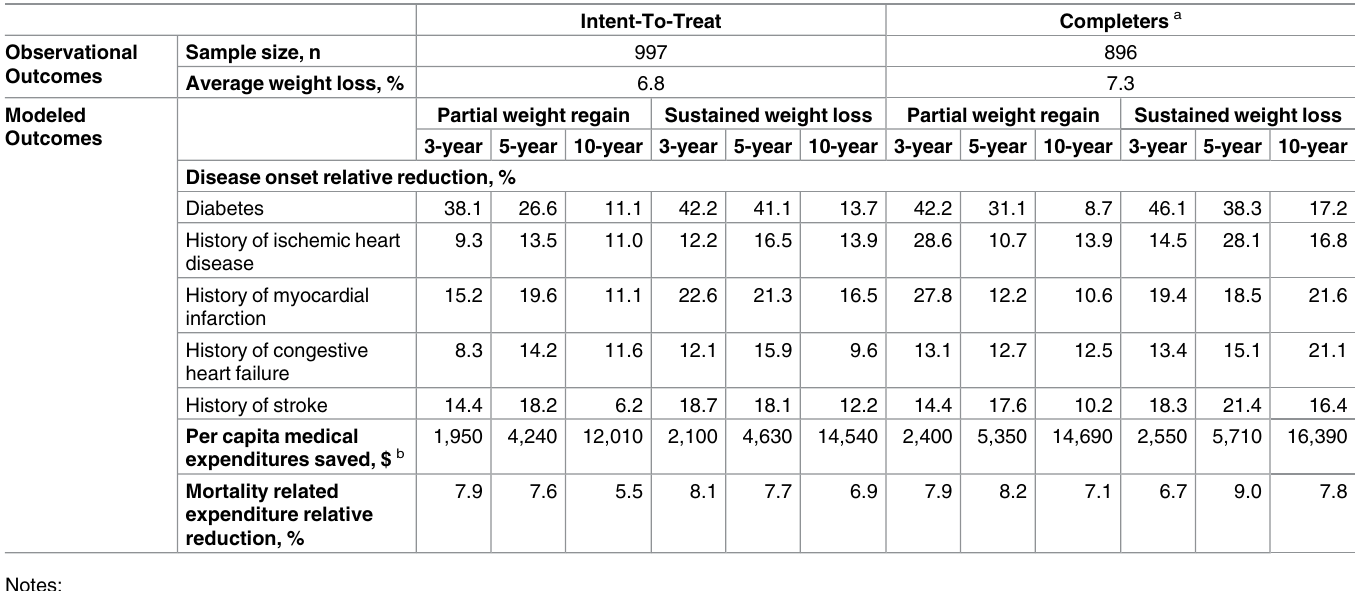
Table 2. Outcomes for Population with Prediabetes and